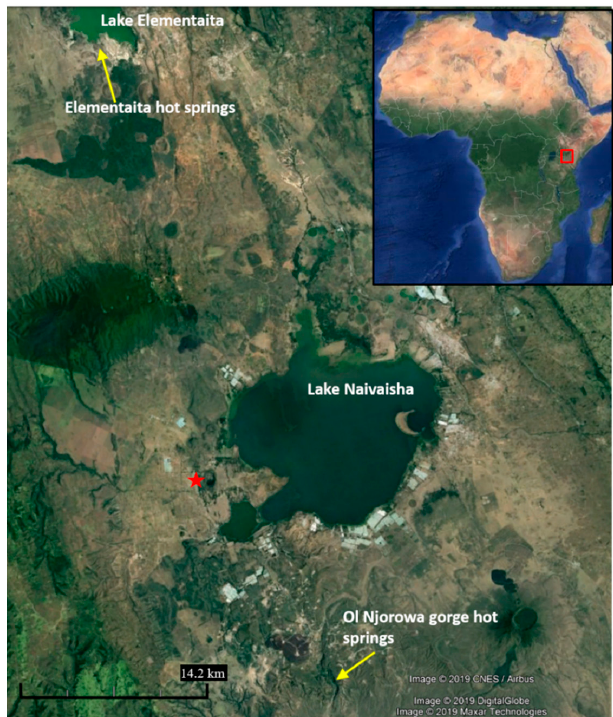
Figure 1. Locations of the sampling sites.The yellow arrows pointthe hot springs Ol Njorowa gorge (ON) and Elementaita (ELM). The red star identifies the Lake Sonachi (SO). The red rectangle in the inset figure locates the studied area within the East African Rift Valley.